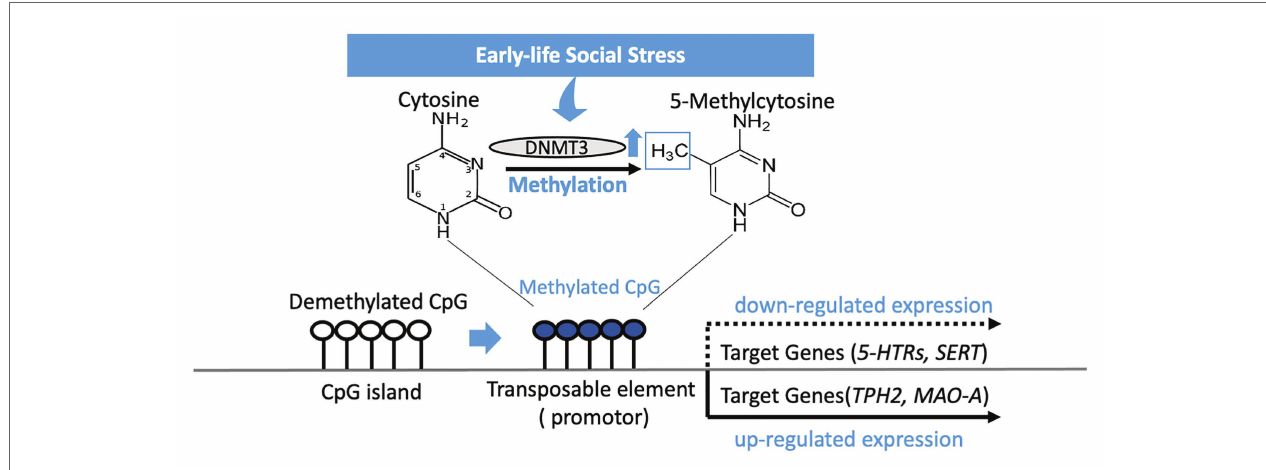
FIGURE 1 | DNA methylation of CpG islands in the genetic code silences expression of a gene after early-life social stress exposure. Methylation occurs by a methyltransferase (DNMT3) transferring a methyl group to cytosine, and when occurring on a transposable element has the effect of repressing gene transcription related to that element. 5-HTRs , 5-HT receptors; SERT , serotonin transporter; TPH2 , tryptophan hydroxylase 2; MAO-A , monoamine oxidase